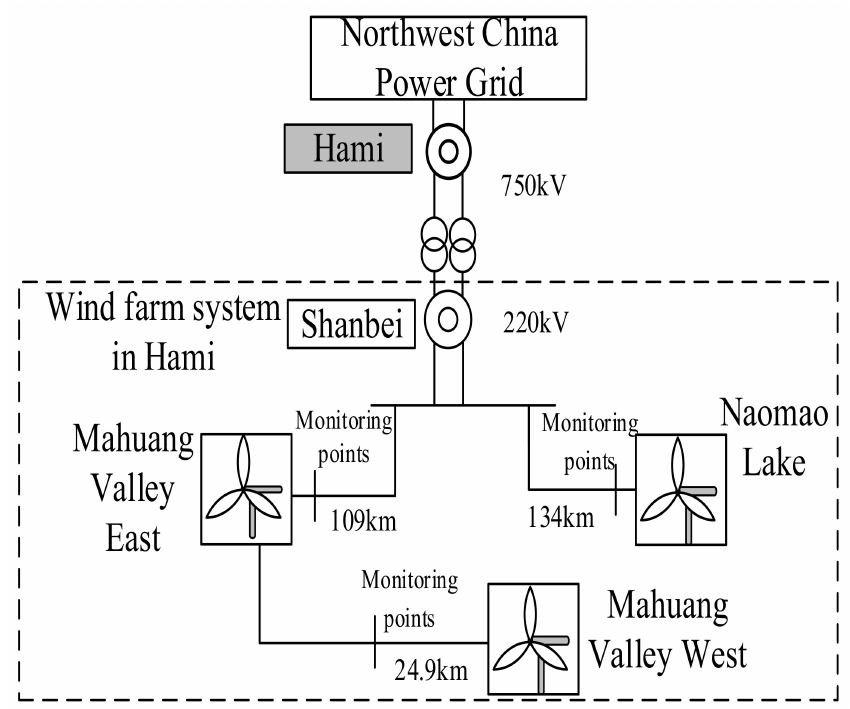
Figure 15. A power grid structure of Hami